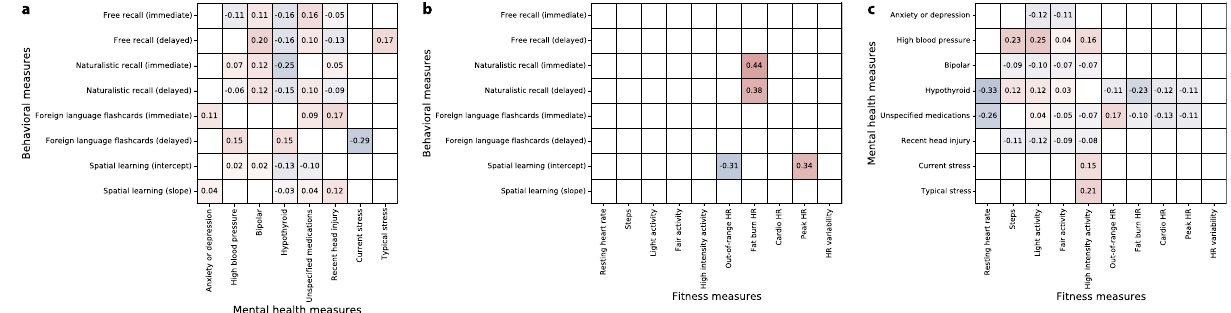
Figure 5. Summaries of correlations between behavioral, fitness, and mental health measures. The reported values in the tables reflect correlations between each pair of measures. Only statistically reliable correlations ( p < 0.05 , corrected) are displayed. ( a ) Correlations between behavioral and mental health measures. We adjusted each task’s behavioral measure(s) such that more positive values reflect better performance on the given task. We used participants’ mean recall accuracies to characterize performance on the free recall and foreign language flashcards tasks, and mean precisions to characterize performance on the naturalistic recall tasks. We characterized performance on the spatial learning task using the (inverted and normalized) intercepts and slopes of linear regressions on mean estimation errors as a function of the numbers of studied shapes (also see Figs. 2, 3, S2, S3, S4, and S5). For each mental health measure, more positive values denote greater severity of the given measure. Typical and current stress levels were measured by self report. Mental health information was inferred using each participants’ list of self-reported medications (see “Methods”). Positive correlations indicate that better performance on a given behavioral task is associated with more severe mental health phenotypes. ( b ) Correlations between fitness and mental health measures. For each fitness measure, more positive values denote higher observed scores (i.e., higher resting heart rate, more minutes of activity or time spent in each heart rate zone, or greater heart rate variability). The mental health measures in this panel were treated as in a . ( c ) Correlations between fitness and behavioral measures. Each measure reflected in this panel was treated as in panels a and b We also found reliable correlations between participants’ fitness and demographic measures and their behaviors in different tasks (Fig. 5; for a complete report, see Fig. S14). For example, recent low-to-moderate- 0.44, p 0.001 ) intensity (“fat burn”) cardiovascular activity was positively correlated with immediate ( r = = 0.38, p 0.031 ) recall performance on the naturalistic memory task. Recent sedentary and delayed ( r = = (“out-of-range”) cardiovascular activity was negatively correlated with performance on the spatial learning task 0.31, p 0.042 ), whereas recent high intensity (“peak”) activity was positively correlated with perfor- ( r = − = 0.34, p 0.0002 ). Mental health indicators, such as self-reported stress mance on the spatial learning task ( r = = levels and medications were also associated with differences in memory (Fig. 5a, Fig. S14). For example, self- reported stress levels at the time of test were negatively correlated with performance on the delayed memory 0.29, p 0.038 ), whereas participants who were medicated test for the foreign language flashcards task ( r = − = for anxiety and depression tended to perform slightly (but reliably) better on the immediate memory test for 0.11, p < 0.0001 ). Mental health indicators were also correlated with the foreign language flashcards task ( r = several fitness measures (Fig. 5c). For example, participants with higher resting heart rates were less likely to be 0.33, p < 0.0001 ). Participants who engaged in more low-intensity (“light”) activity tended to hypothyroid ( r = − 0.12, p 0.03 ), whereas participants who engaged in more high-intensity be less anxious and depressed ( r = − = 0.15, p 0.027 ) and typical ( r 0.21, p 0.012 ) stress. activity tended to report higher levels of current ( r = = = = The above analyses indicate that recent differences in fitness-related activity are associated with differences in memory performance and mental health measures. Although the analyses treated these measures on average or in aggregate, many of the measures we collected are dynamic. For example, the amount or intensity of physical activity people engage in can vary over time, and so on. We wondered whether the dynamics of fitness-related measures might relate to memory performance and/or mental health measures. To this end, we carried out a series of reverse correlation analyses (see “Reverse correlation analyses”) to examine whether participants with different cognitive or mental health profiles also tended to display differences in fitness-related measures over time. In particular, we examined fitness data collected from participants’ Fitbit devices over the year prior to their test day in our study. Several example findings are summarized in Fig. 6. We found that participants who performed well on the immediate and delayed free recall memory tests and on the naturalistic recall tests tended to be more active than participants who performed poorly on those tests (Fig. 6a,b; Fig. S15). Conversely, participants who performed well on the immediate and delayed foreign language flashcards tasks tended to be less active. These differences were present even a full year before the testing day. We also found substantial vari- ability across people with different (self-reported) mental health profiles (Fig. 6; Fig. S18). Due to small sample sizes of individuals exhibiting several mental health dimensions, it is difficult to distinguish generalizable trends from individual differences that one or two individuals happened to exhibit. However, several large-sample-size trends emerged. For example, participants who reported higher levels of stress also tended to be slightly more physically active than participants who reported lower stress levels. We found analogous differences in other activity-related measures (Figs. S15 and S18), cardiovascular measures (Figs. S16 and S19), and sleep-related